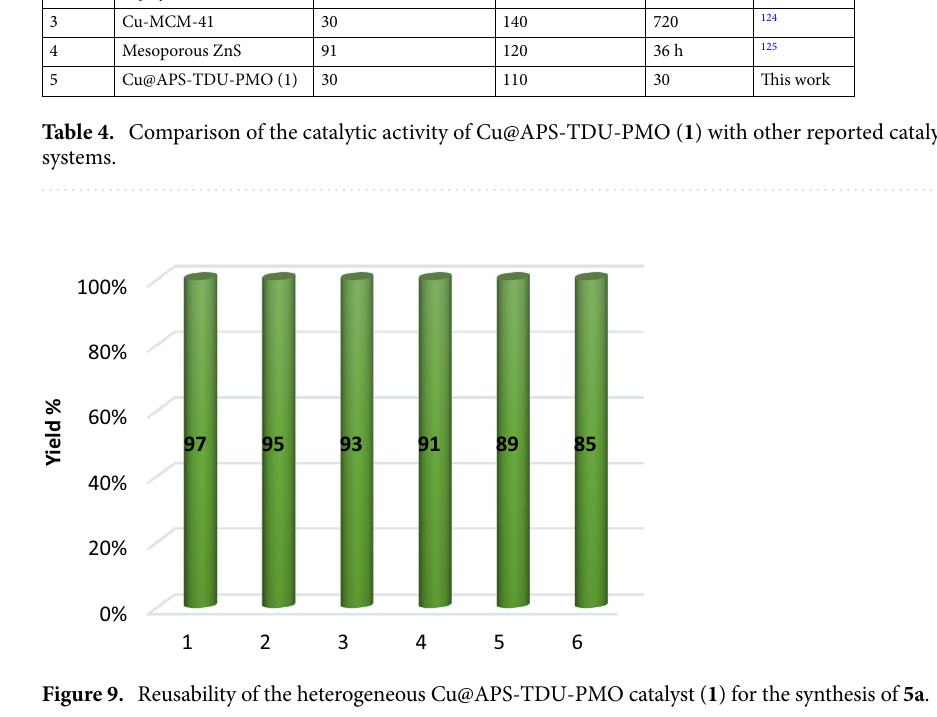
Figure 9. Reusability of the heterogeneous Cu@APS-TDU-PMO catalyst ( 1 ) for the synthesis of 5a